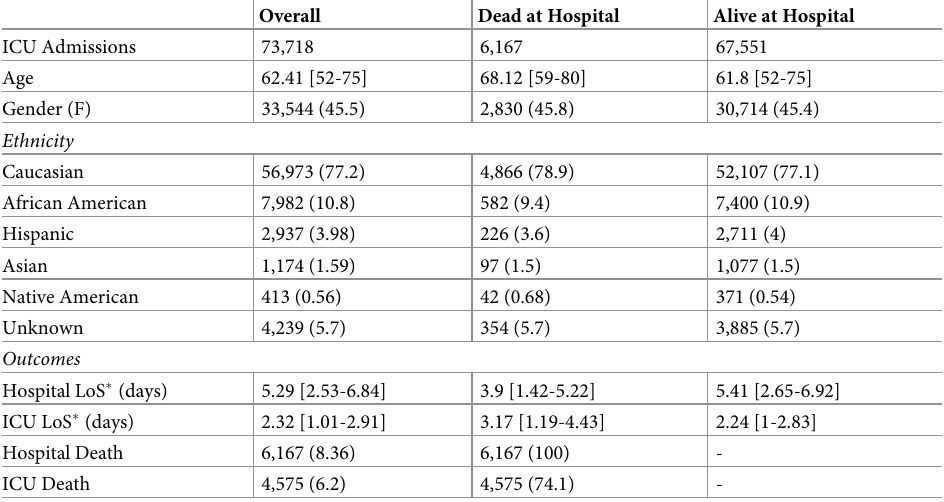
Table 1. Characteristics and mortality outcome measures. � LoS (Length of Stay). Continuous variables are presented as Median [Interquartile Range Q1–Q3]; binary or categorical variables as Count